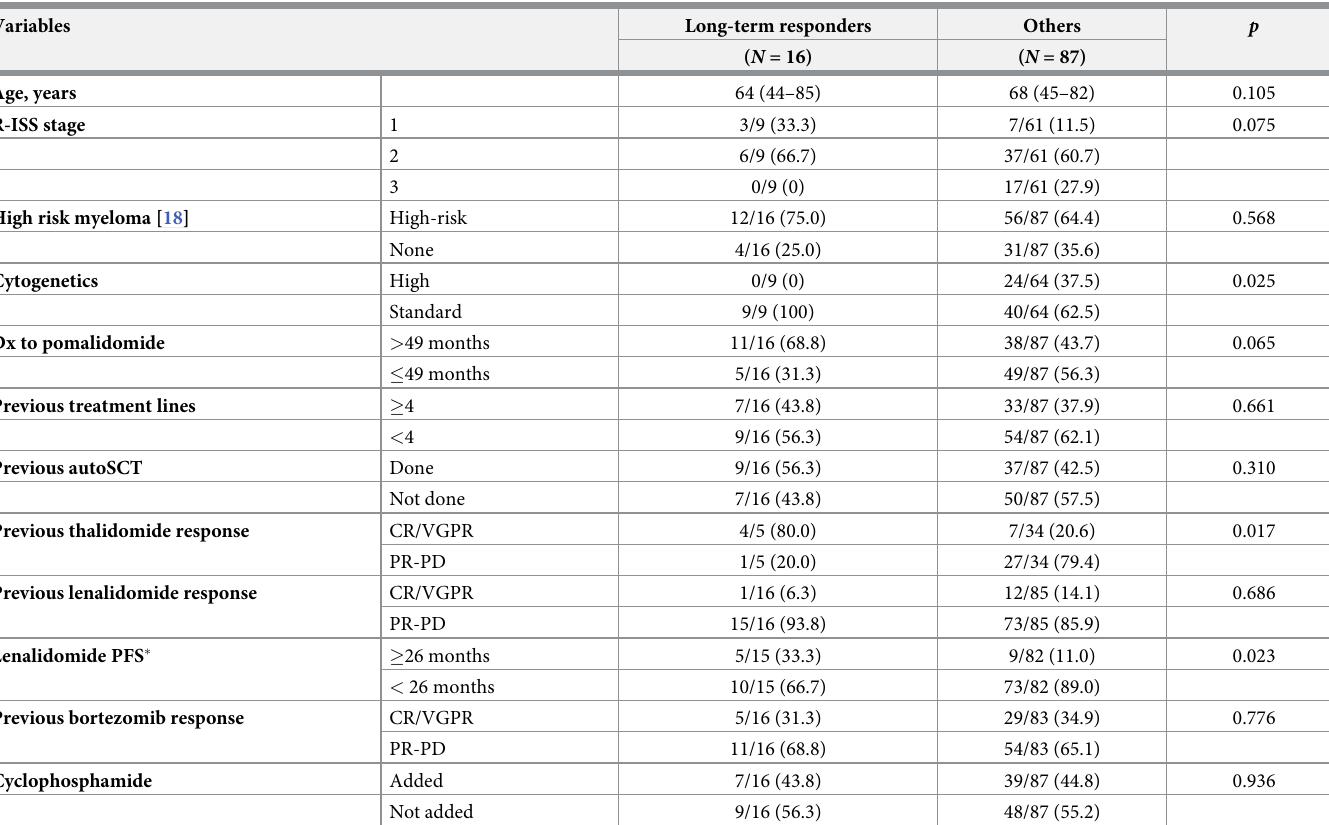
Table 4. The comparison between patients with long duration of response to pomalidomide (upper 15% of progression free survival) versus